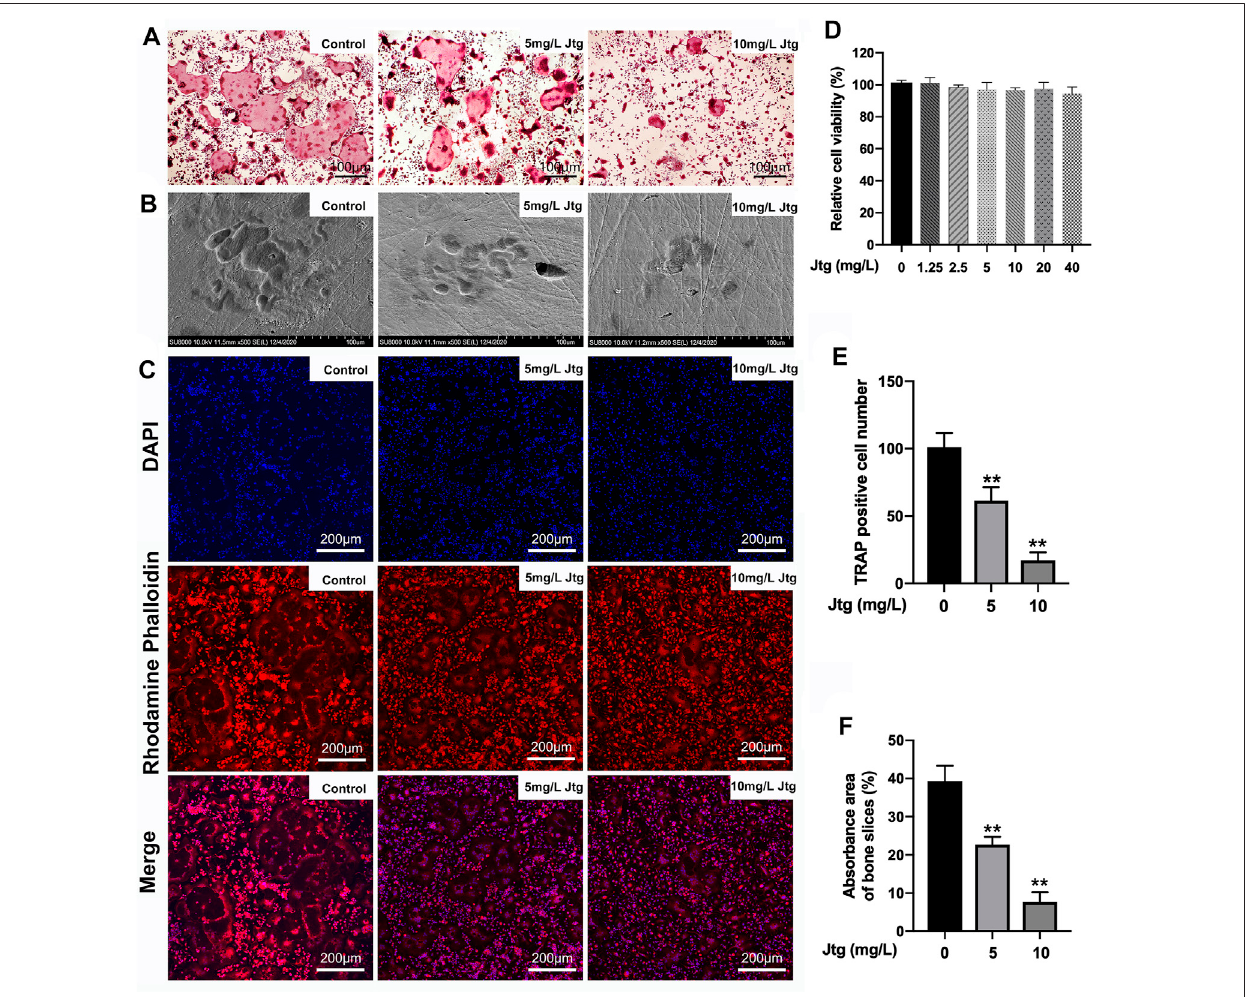
FIGURE1| Jtg preventsreceptor activator ofnuclear factor-kappa Bligand (RANKL)-induced osteoclastogenesis in vitro . (A) Tartrate-resistant acidphosphatase (TRAP) staining of osteoclasts treated with different concentrations of Jtg. (B) Representative SEM images of bone resorption pits. (C) Representative images of actin rings formation were observed with confocal microscopy. (D) BMMs were treated with various concentrations of Jtg for 24 h and cell survival was measured using a CCK-8 assay. (E) The number of TRAP-positive cells (containing three or more nuclei) were determined. (F) The total areas of resorption pits were measured. *Compared with the control group (** p <